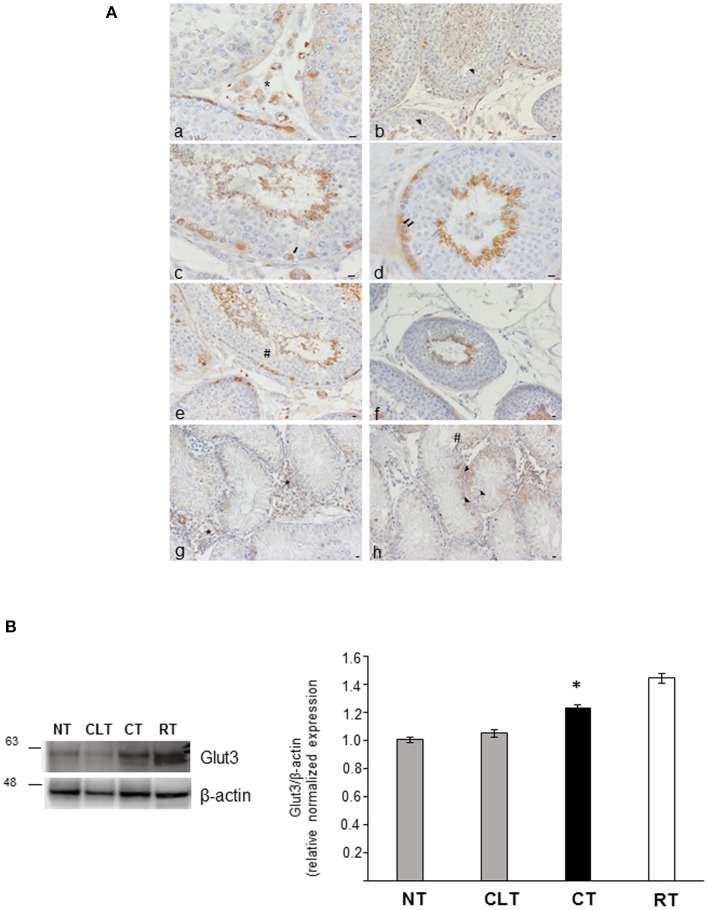
(A) Glut3-IR in cytotypes of normal and cryptic gonad of dogs. (a,g) A large group of Leydig cells positive to Glut3 in NT and CT (asterisk) were found; (b,h) Glut3-IR were described in the apical and basal portions of the cytoplasm of Sertoli cells (arrowhead) in NT and CT; (c,d) few spermatogonia (c) and resting or pre-leptotene spermatocytes (d) positive to Glut3 were found along the basal membrane of the testicular tubule of NT (arrow and double arrow, respectively); (e,f) round or immature (e) and elongated or mature (f) spermatids were localized toward the tubular lumen (hashtag) in TN. Bar: 50 μm. (B) Western blot analysis of Glut3 protein expression level in the canine NT, CLT, and CT. Samples from rat testis (RT) were blotted as positive controls. In all the examined tissues, Glut3 appears as a band at ~ 56 kDa. A significative increase in Glut3 expression is observed in CT respect to NT and CLT (densitometric analysis). Data are expressed as mean ± SD (n = 5 samples/group), *p < 0.01.